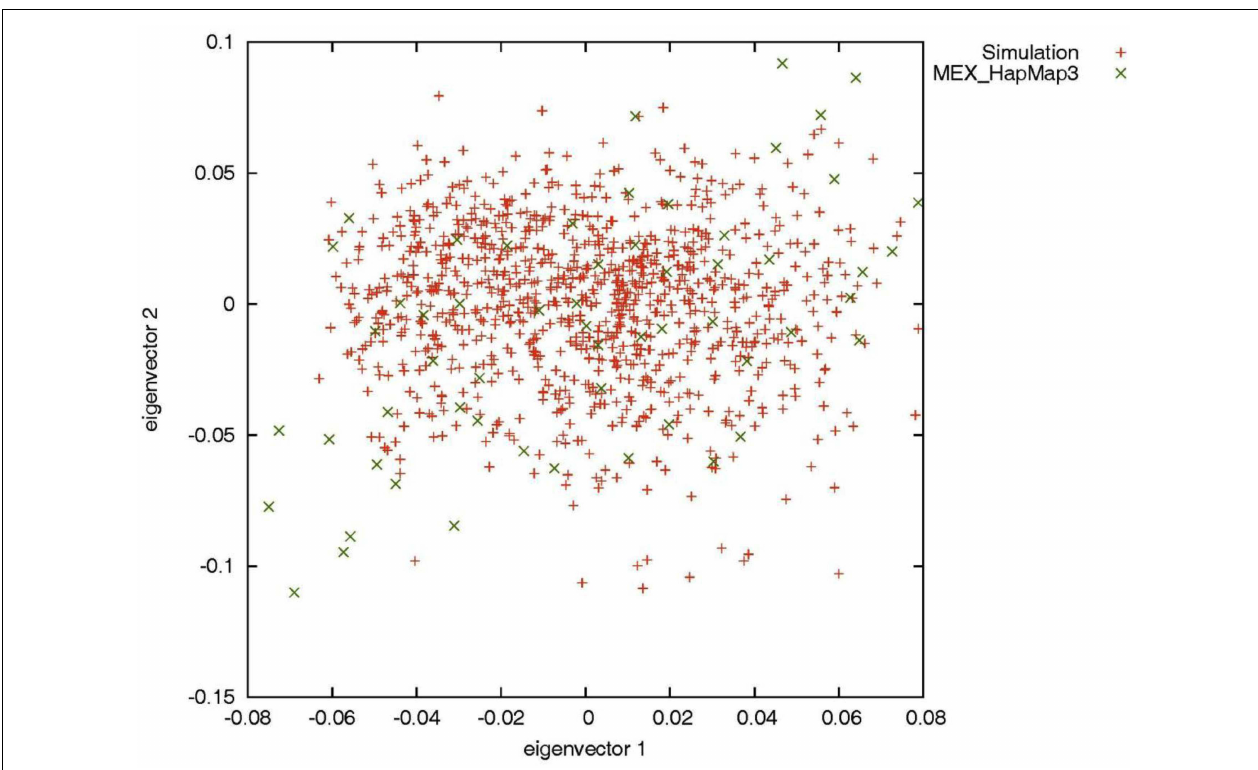
FIGUREA1 | Principal components analysis of the simulated individuals and the HapMap Mexican–American